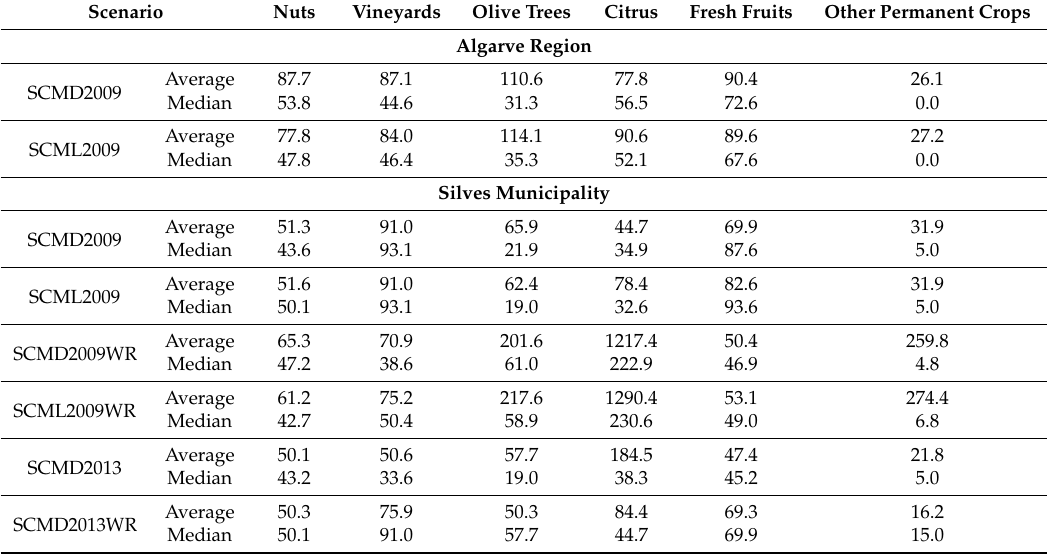
Table 2. The average and median PAD indicator per crop type and simulation in the Algarve region and Silves municipality.